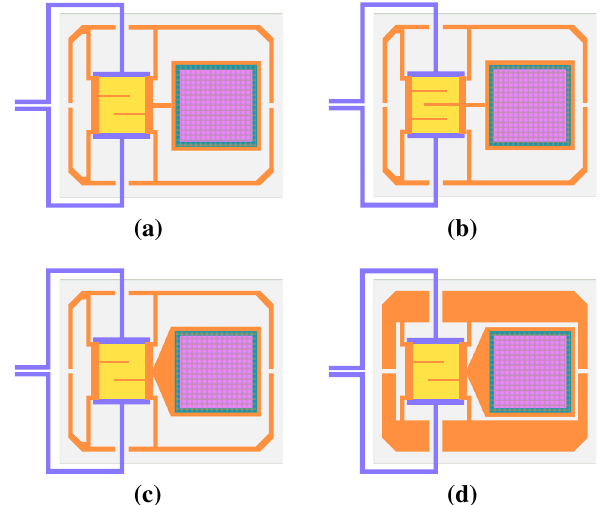
Fig. 2 The four detector variants that have been tested: the baseline design a displays a gold absorber (light purple) thermally linked by means of a copper element (orange) to the temperature sensor (yellow); the latter is connected to the bias and read-out circuit through electrical contacts (dark purple). The sensor is also linked to a copper structure that is intended to extend the external perimeter in order to increase the thermal conductance toward the thermal bath and hence shortening the fall time of the pulses. The entire structure is suspended by means of a Si 2 N 3 membrane (light gray). In b the sensor has one extra bar in the meander. The design c differs from a for the different thermal coupling between absorber and sensor. Finally, the d version differs from c for an increased mass of copper in the radiating structure: this increases the